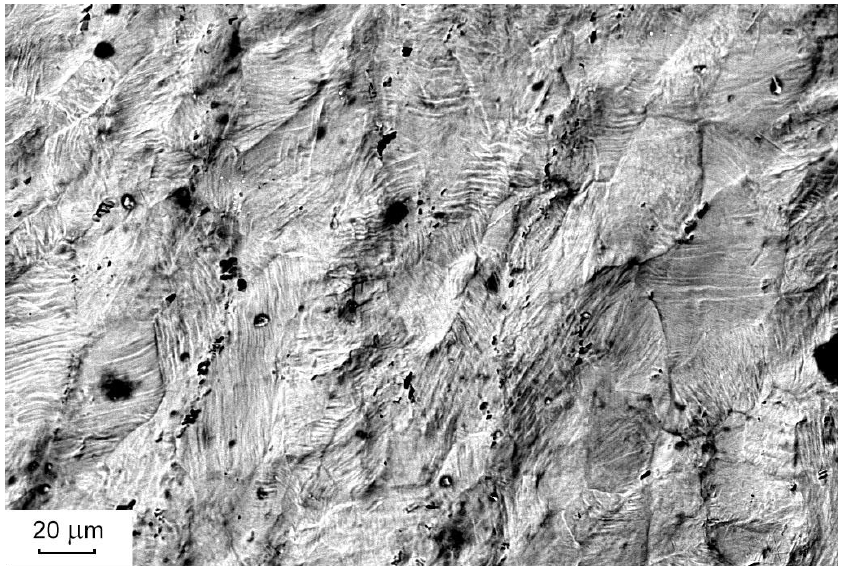
Figure 6. Deformation-induced surface microrelief after torsion at 299 K of coarse-grained speci- men of Ti 49.3 Ni 50.7 (at%) alloy (details in text). Scanning electronic microscopy. of Ti 49.3 Ni 50.7 (at%) alloy (details in text). Scanning electronic